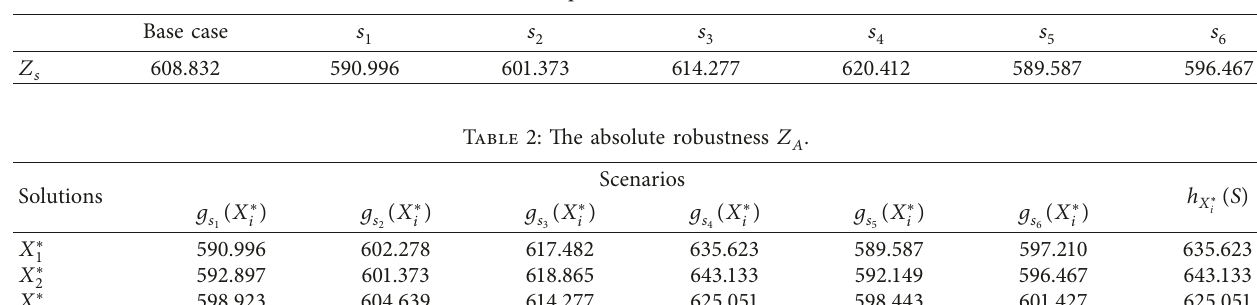
Table 1: The optimal value of each scenario.